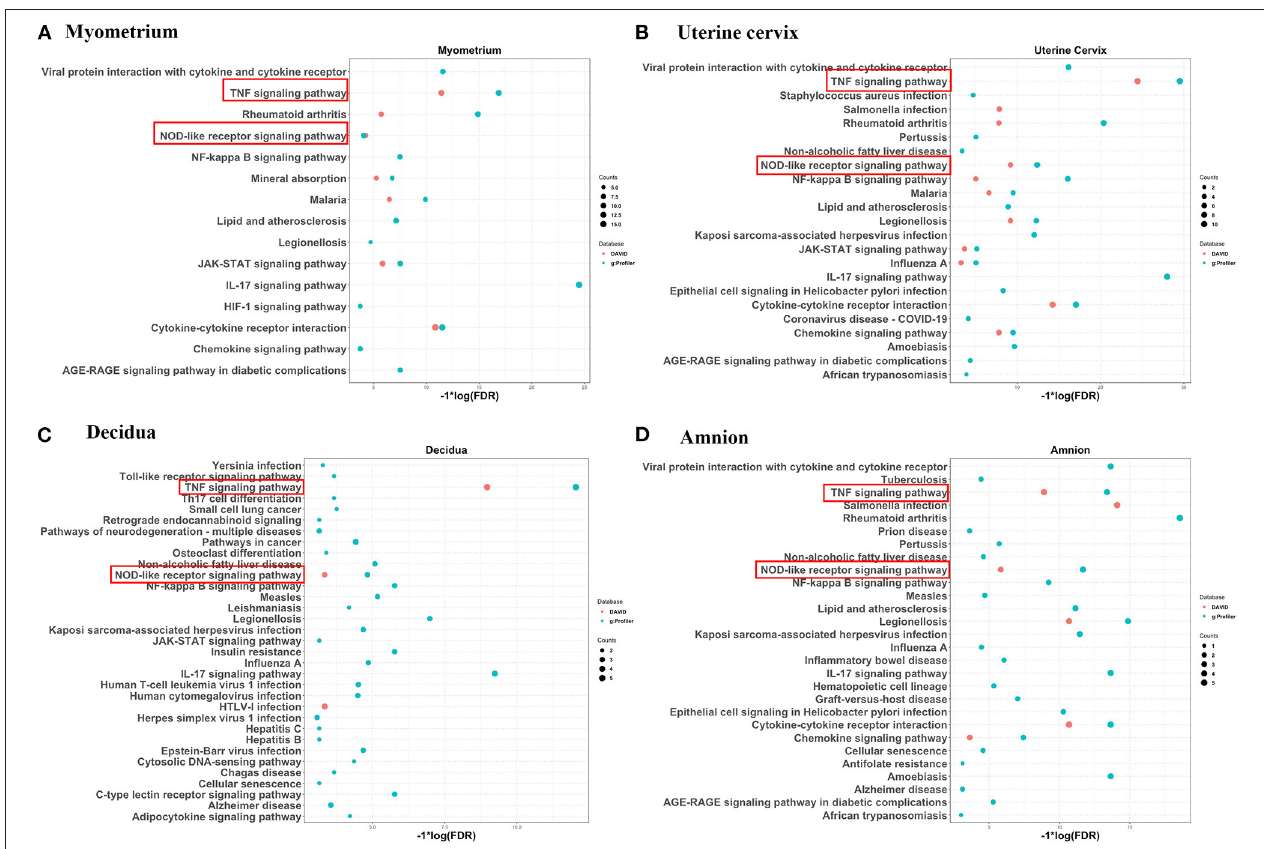
FIGURE 2 | Significantly overrepresented KEGG pathways for significantly increased genes identified by two or more studies in myometrium (A) , uterine cervix (B) , decidua (C) , and amnion (D) using DAVID and g:Profiler. KEGG pathways overrepresented in four mentioned gestational tissues were marked by red rectangle. Red dots represent enriched pathways identified by DAVID and blue dots represent pathways identified by g:Profiler. Size of dots represents the gene counts in our gene list involved in the corresponding